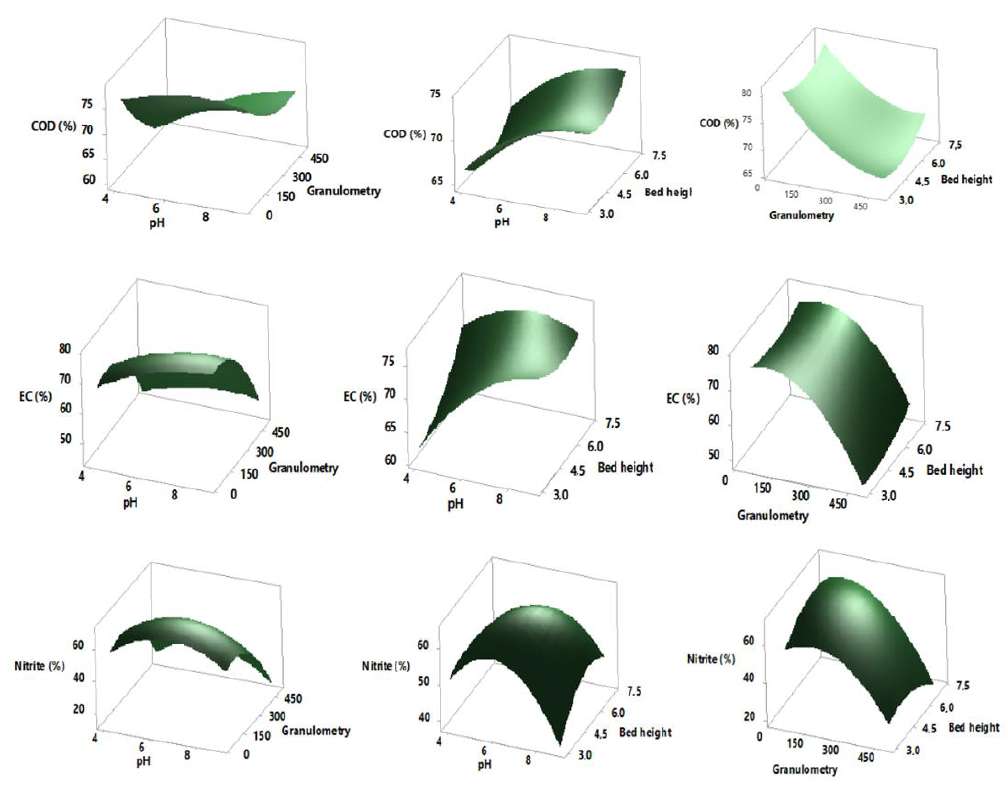
Figure 7. Surface diagram of EC RP (%), nitrite RP (%) and COD RP (%).